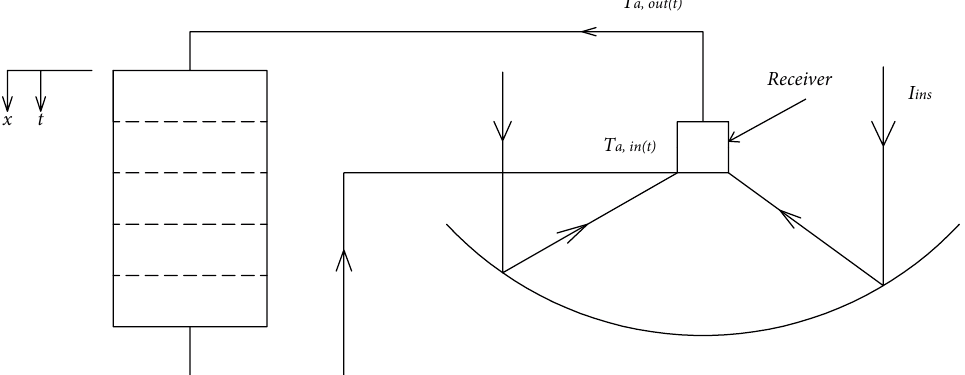
Figure 5: Schematic diagram showing the heat transfer process in integrated packed bed with parabolic solar collector.